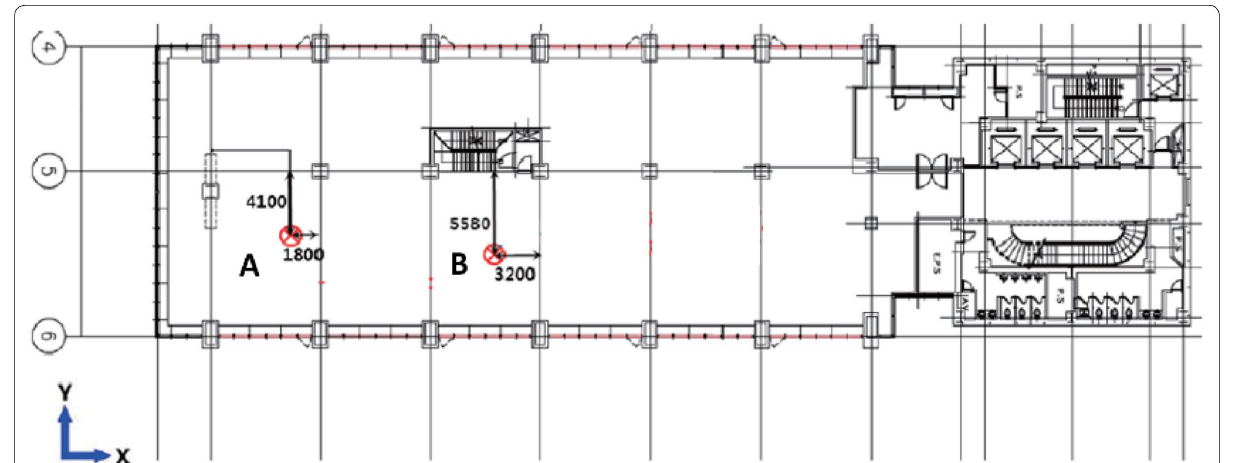
Fig. 10 Plan view of the top floor and measurement layout.